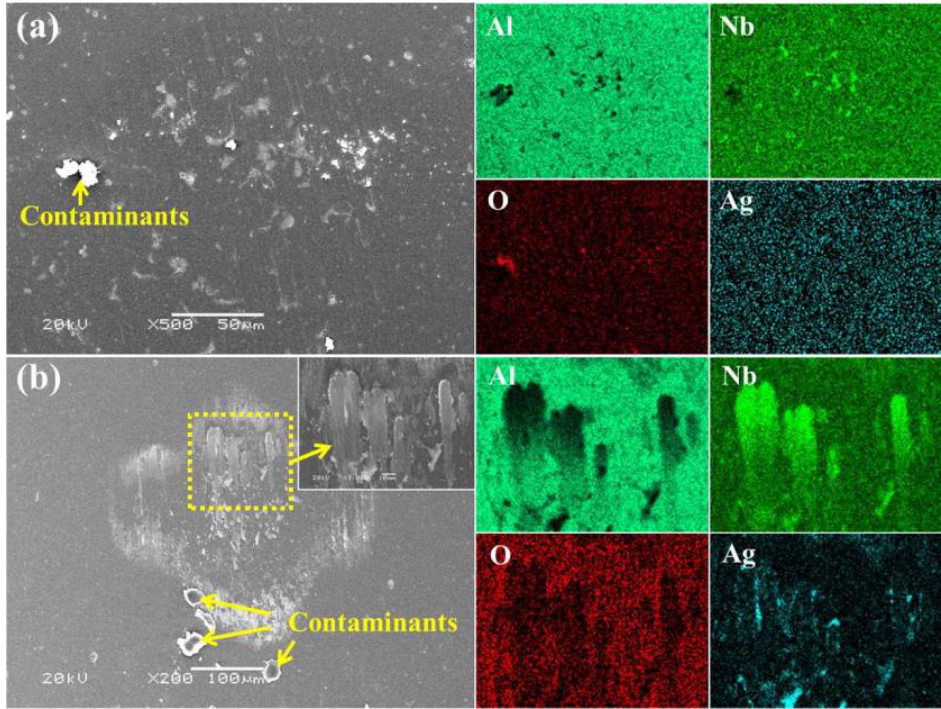
Figure 9. Wear scars for Al 2 O 3 balls after sliding against NbN film ( a ) and NbN-Ag film ( b ), as well as corresponding EDS maps.